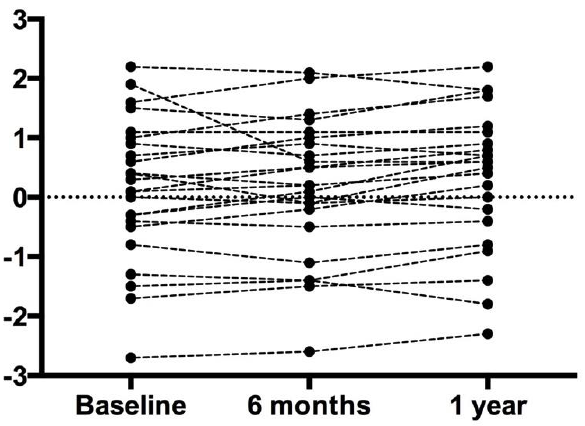
Figure 2. Lumbar T-Score. Each circle represents an individual data point. Despite the slight variation in individual data, the overall group mean did not change.